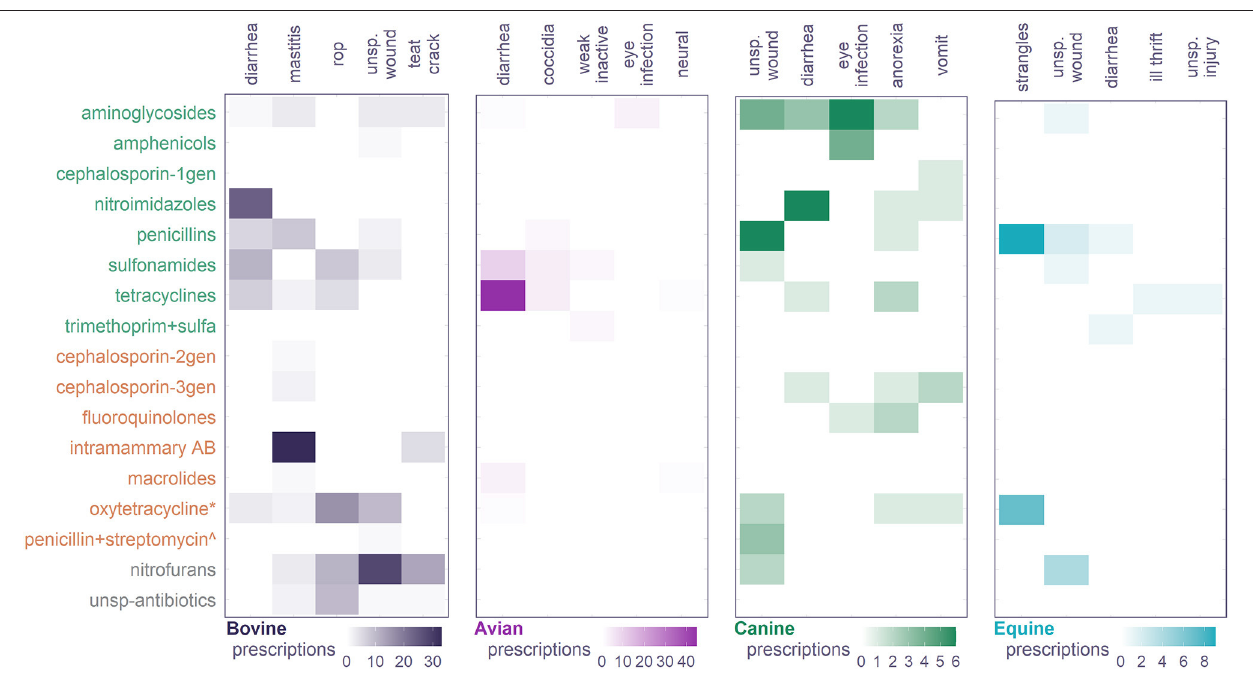
FIGURE 4 | Top 5 diagnosis most frequently treated with antibiotics and associated antibiotic class prescription. Antibiotics classes are colored according to the AWaRe index ; green: access ; amber: watch ; gray: unclassified . * and ∧ were separated from their classes as these drugs have different classification. Unsp. wound, unspecific wound; rop, retention of placenta; neural, unspecific neurological signs including lethargy and ataxia; unsp. injury, unspecific injury; miscellaneous, unspecific signs including swollen, stress, and unconnected terms including “preventive” and “no diagnosis”.